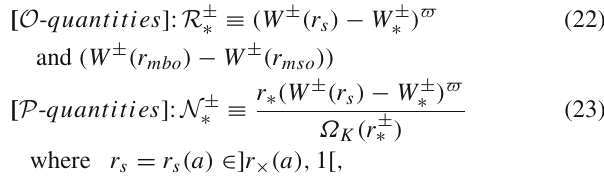
lerian (relativistic) angular frequency, W s ≥ W × is the value of the equipotential surface, which is taken with respect to the asymptotic value, W × = ln K max is the function at the cusp (inner edge of accret- ing torus), D ( n ,κ), C ( n ,κ), A , B are functions of the polytropic index and the polytropic